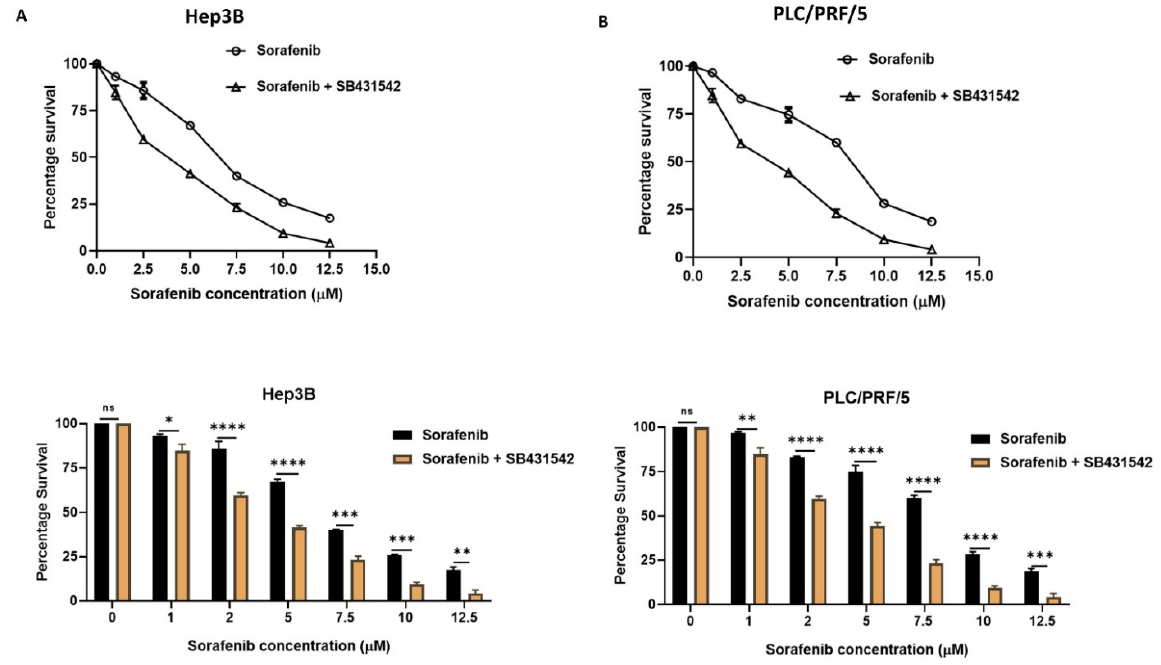
Figure 6. EMT inhibition with SB431542 enhanced the cytotoxic effects of Sorafenib. Cell viability assay revealed increased cytotoxicity of Sorafenib when combined with SB431542 in comparison to Sorafenib alone in ( A ) Hep3B-derived spheres and ( B ) PLC/PRF/5-derived spheres. ( n = 3, * p < 0.05, ** p < 0.01, *** p < 0.005, **** p < 0.001, ns: not significant).